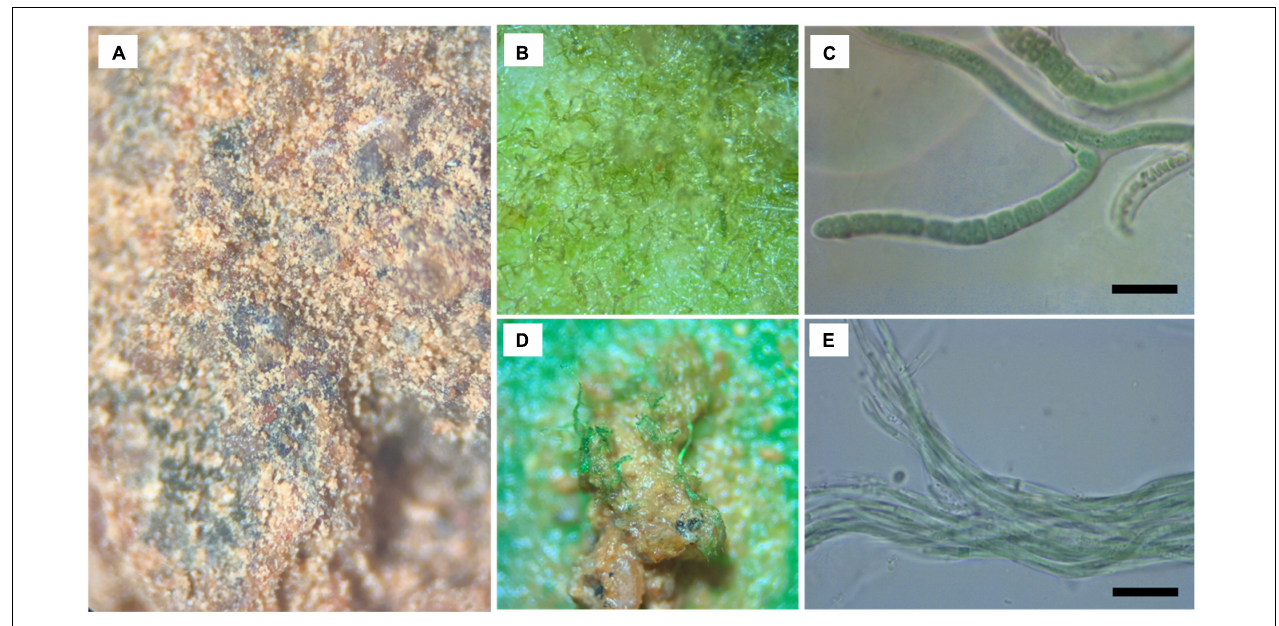
FIGURE 4 | (A) Microscope view of regenerating biocrust and identified (most abundant) cyanobacteria from the regenerating biocrust sample. (B,C) Scytonemataceae filaments from culture conditions, and (D,E) Oscillatoriales filamentous from culture conditions. Scale bars in (C,E) are 20 µ